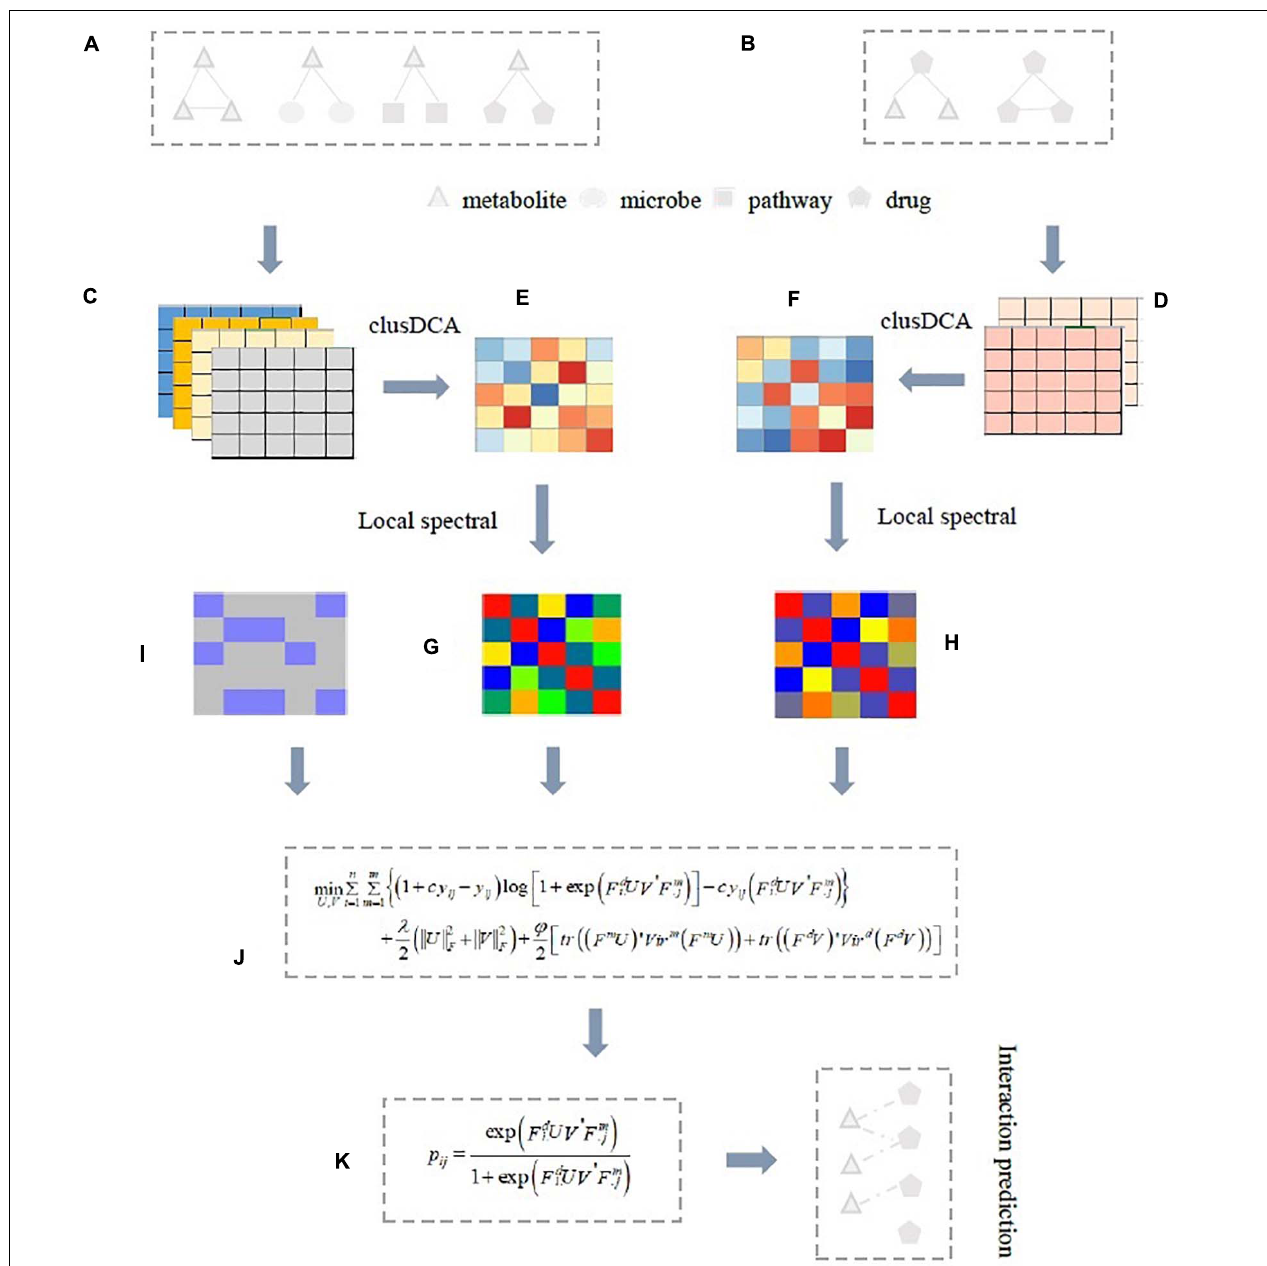
FIGURE 1 | Illustrative example of ILMF for predicting potential drug-metabolite associations. (A) Metabolite–metabolite, metabolite-drug, metabolite-microbe, metabolite-pathway association matrices, or correlation matrices; (B) Drug-metabolite, drug–drug association, or correlation matrices; (C,D) Based on Gaussian interaction profile kernel function, metabolite–metabolite similarity matrices, and drug–drug similarity matrices obtained from four metabolite association data and two drug association data, respectively; (E) The fused metabolite–metabolite similarity matrix by integrating four metabolite-related data with clusDCA; (F) The fused drug–drug similarity matrix by integrating two drug association data with clusDCA. Then, the local spectral matrix of metabolites (G) And the local spectral matrix of drugs (H) Can be obtained based on these two fused similarity matrices with Vicus; (I) The drug-metabolite association matrix; (J) The proposed ILMF model. Finally, ILMF outputs the predicted drug-metabolite interaction probability scores (K) . Here, a solid line indicates known associations, a dotted line indicates predicted drug-metabolite associations obtained from ILMF.